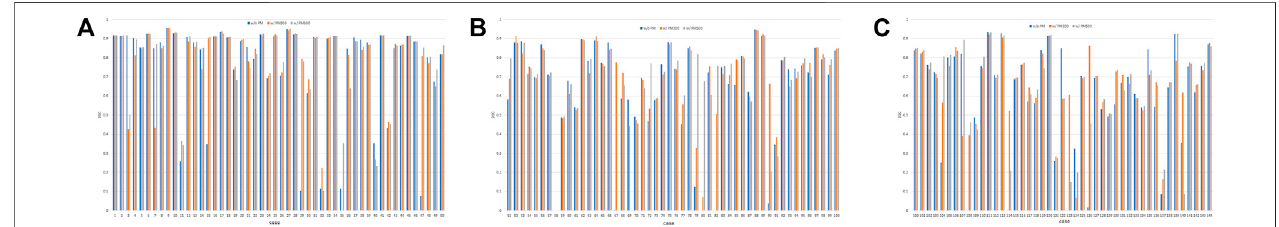
FIGURE6| DSCvaluesofthetestsetwhenusingDecathlon mid withandwithoutthepretrainedmodel. (A) Cases1 – 50, (B) cases51 – 100,and (C) cases101 – 144. Note: DSC values are obtained with models obtained from 500 epochs of training. Abbreviation: PM, pretrained model; PM 300 , pretrained model obtained from 300 epochs of training; PM 500 , pretrained model obtained from 500 epochs of